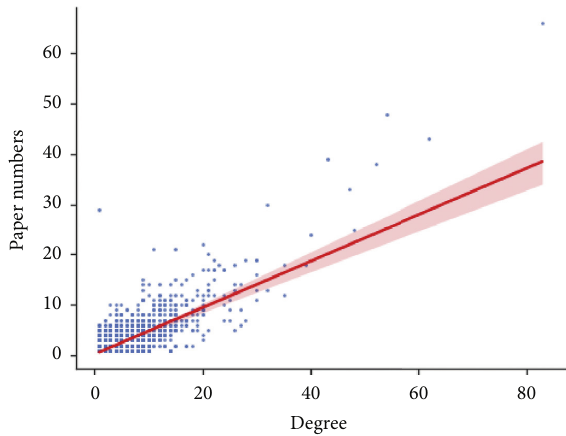
Figure 6: Scatter diagram and regression curve of correlation between the number of papers and degree